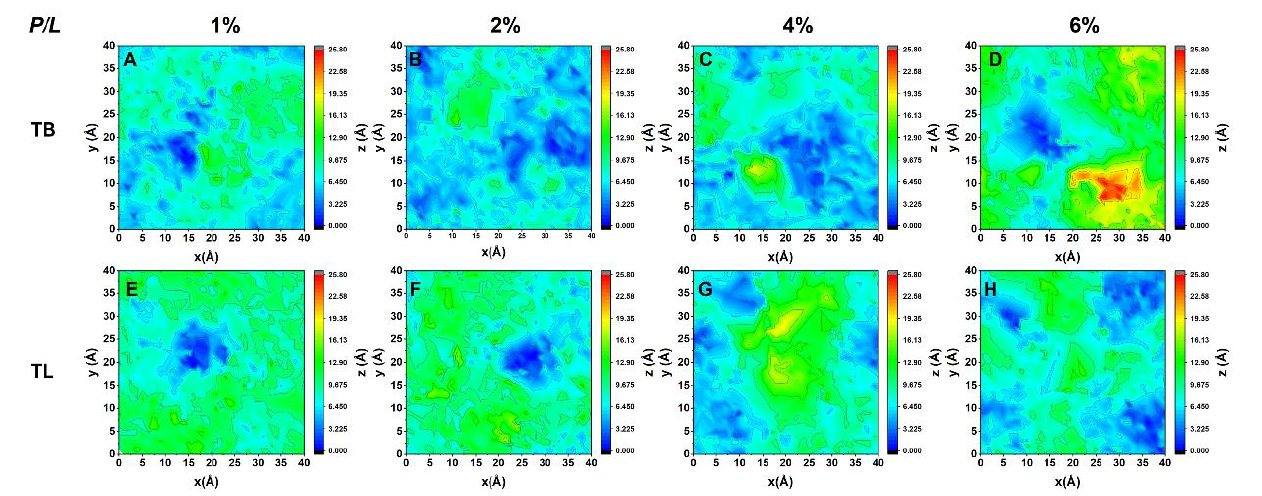
Figure 3. The 2D lipid height map of TB- and TL-treated bilayer membrane. The height of phospholipid was defined as the distance between a phosphorous atom in the peptide-bound leaflet relative to the lowest phosphorous atom in the same leaflet in the bilayer normal direction.